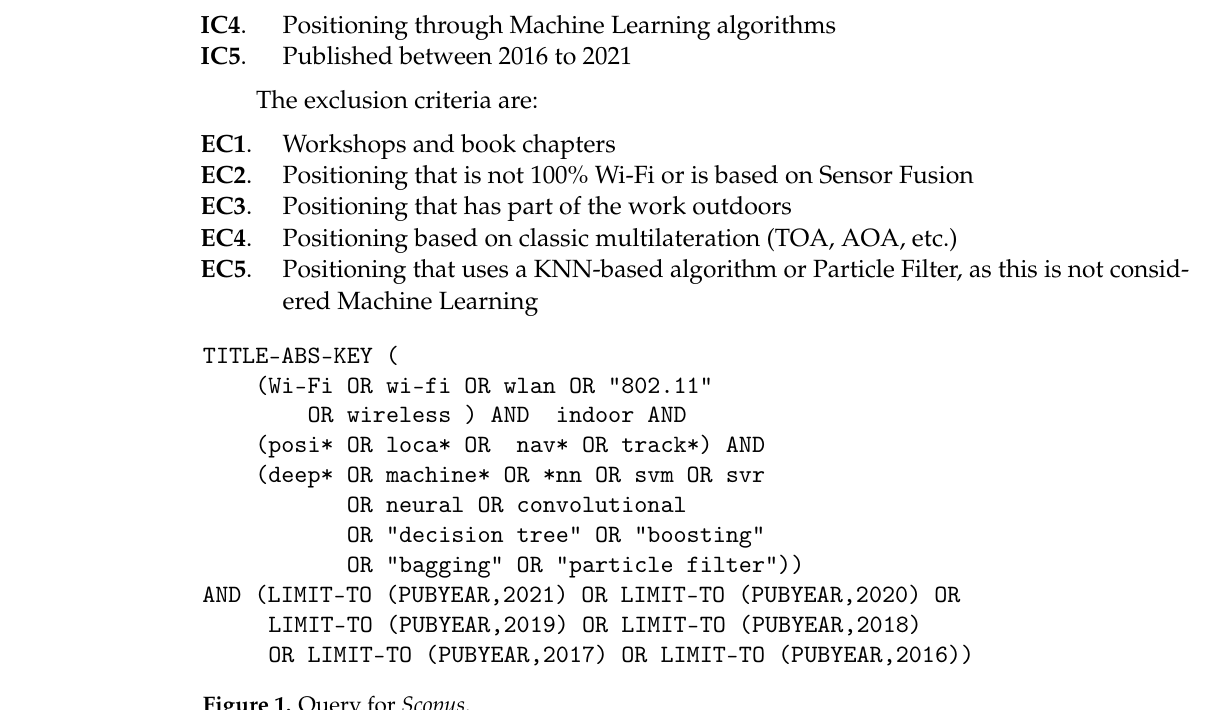
Figure 1. Query for Scopus .